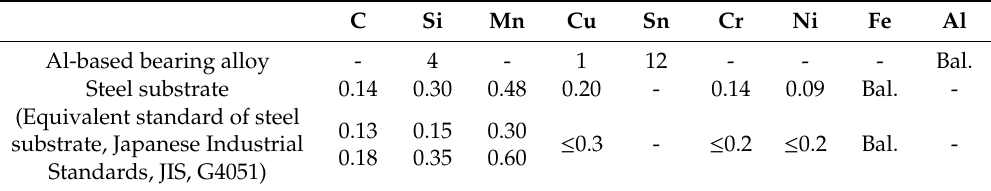
Table 1. Chemical compositions of Al-based bearing alloy and low carbon steel substrate